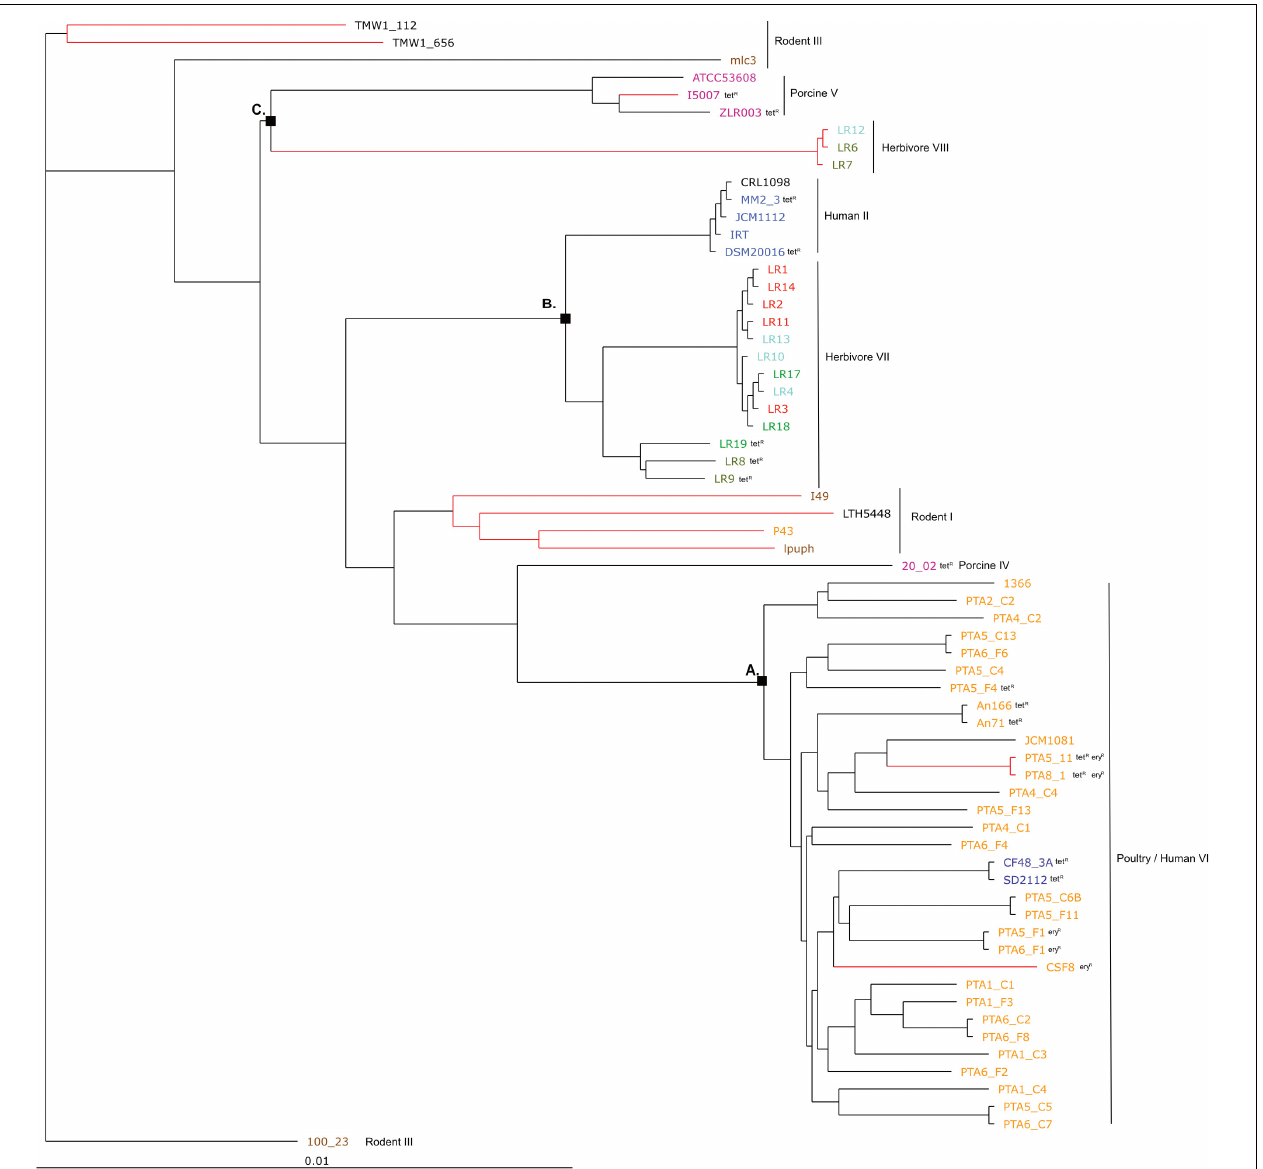
FIGURE 3 | Phylogenetic tree based on core genes of 65 L. reuteri strains from different hosts (25 genomes from this study and 40 from NCBI, Supplementary Table S1 ) based on the neighbor-joining method (PHYLIP implementation). Different colors represent different hosts, blue: human; yellow: chicken; pink: pig; brown: mouse/rat; light blue: cow; red: goat; green: horse; brown/green: sheep; black: sourdough. The red branches indicate the reuterin-negative strains. A, B and C indicate identified clusters in the gene content tree ( Figure 1 ). Strains which harbor AMR genes for tetracycline (tet) and erythromycin (ery) are indicated as tetR and eryR,